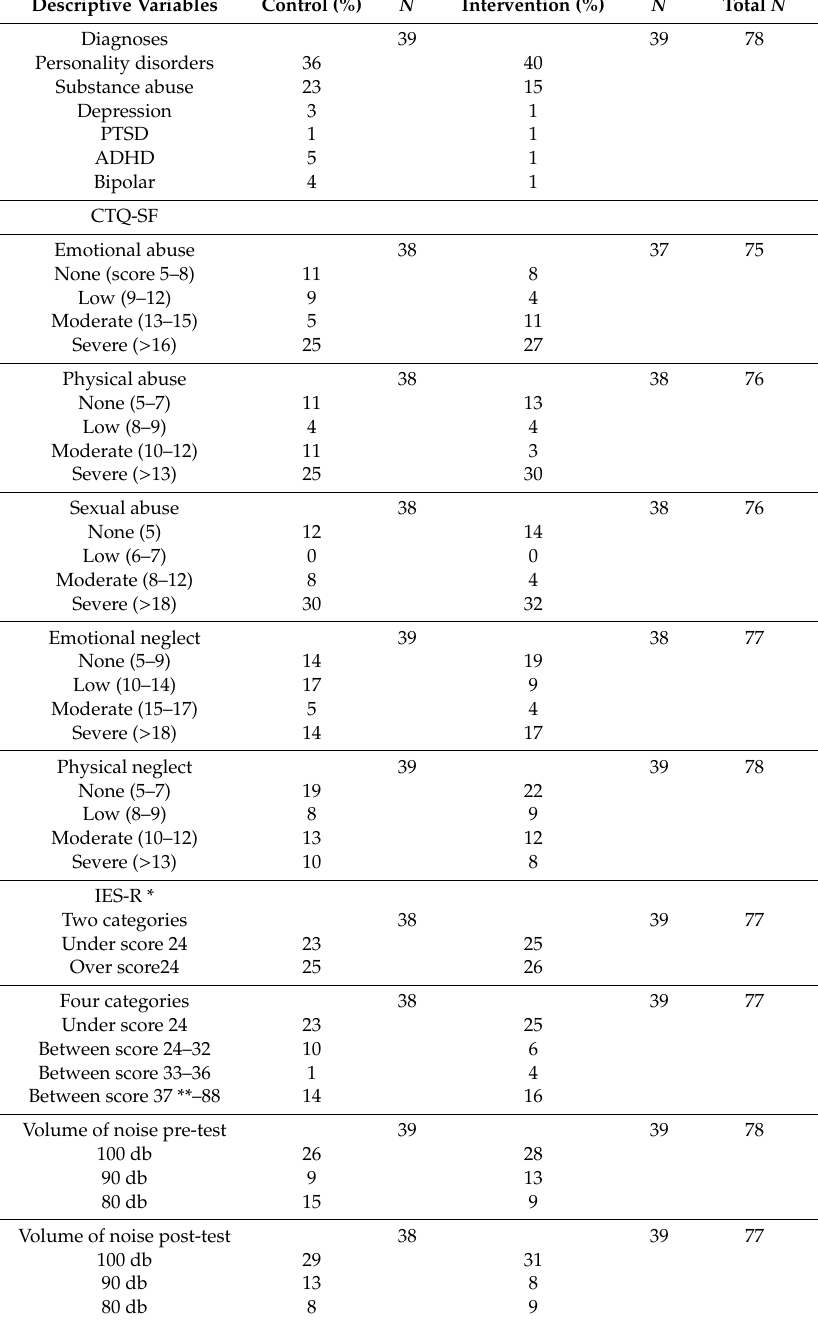
Table 1. Descriptive statistics of the participants such as psychiatric characteristics (i.e., diagnoses), scores on the Childhood Trauma Questionnaire-Short Form (CTQ-SF) and Impact of Event Scale-Revised (IES-R), as well as volume of noise during performance of experimental tasks for the Control group and Intervention group (25(OH)D). Number of participants ( N ) are shown in